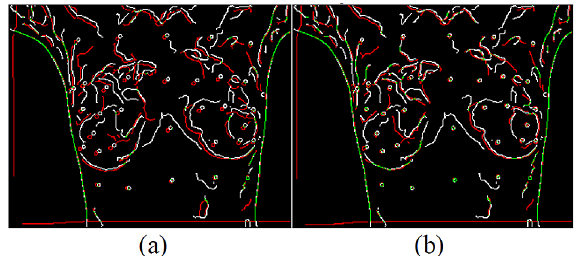
Figure 19. Registration results ( a ) without matching pairs and ( b ) with added matching pairs.